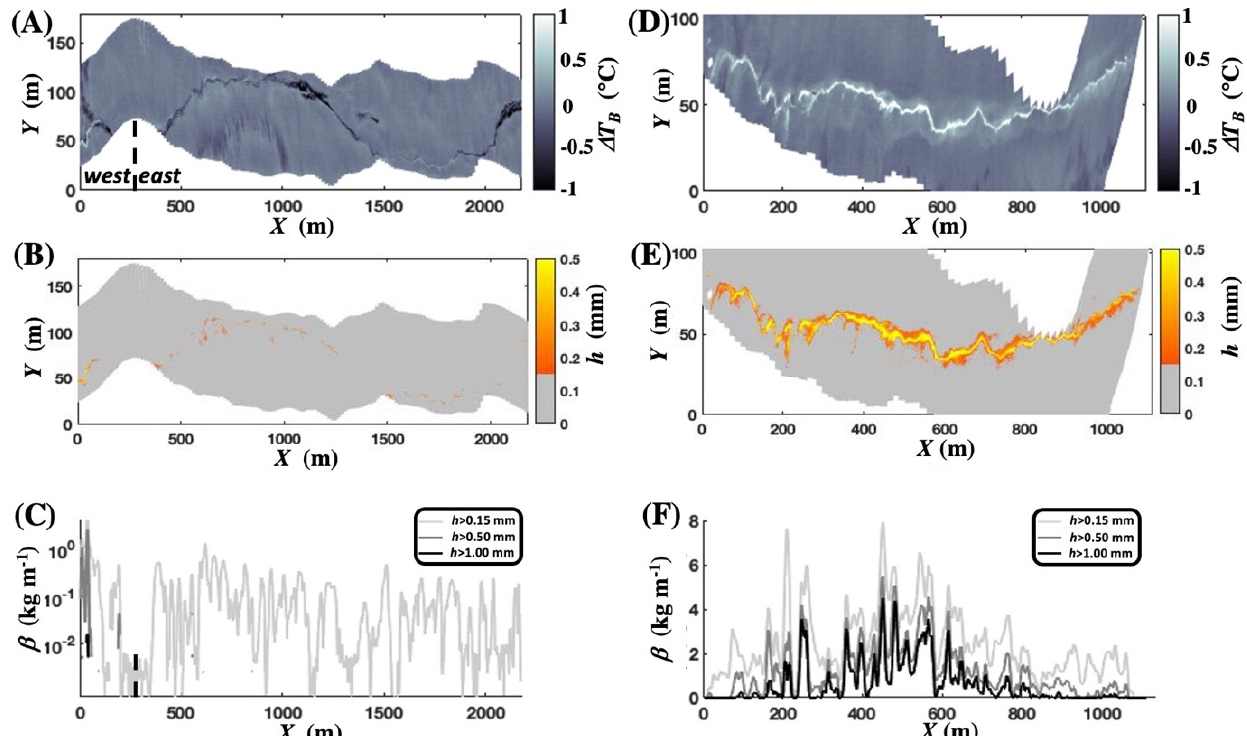
Figure 10. ( A ) Oil brightness temperature contrast, ∆ T B , map, ( B ) slick thickness, h , map based on empirical calibration (east and west slicks labeled were considered distinct), and ( C ) along-slick linear mass ( β ), by integrating 刘 h ( X , Y ) dY , where X and Y are along-slick and cross-slick distances, respectively, for imagery acquired 23 May 2016. ( D ) ∆ T B map, ( E ) h map and ( F ) β for imagery acquired 25 May 2016. Data keys on